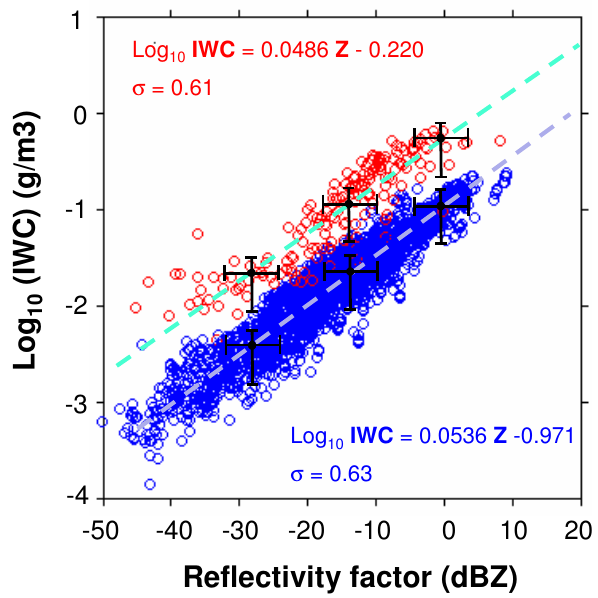
Fig. 9. IWC-Z relationships for the convective overshooting cloud and the cirrus observations (red and blue symbols, respectively). The slope parameters and correlation coefficients are reported. Hor- izontal and vertical bars represent the uncertainties on the equiva- lent radar reflectivity ( ± 4dBz) and on the ice water content (100%) derivations,